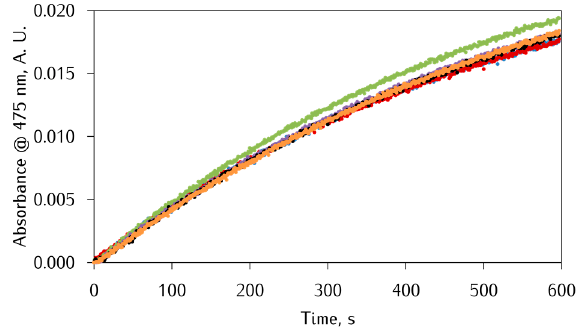
Figure 11. Kinetic traces of 3 mM DA in Hepes bu ff er pH 7.4 and 37 °C (blue) in the presence of 25 µM of Cu(II) (red) and increasing amounts of Ac- α S 119–132 (0.5 eq: green, 1 eq: purple, 1.5 eq: black, 2 eq: orange). The DA autoxidation (without copper or peptide) overlaps with the lower, purple, trace.